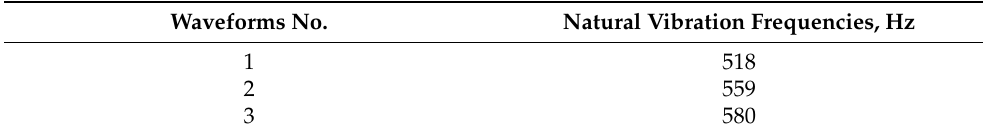
Table 4. Internal panel natural frequencies and vibration modes. Waveforms